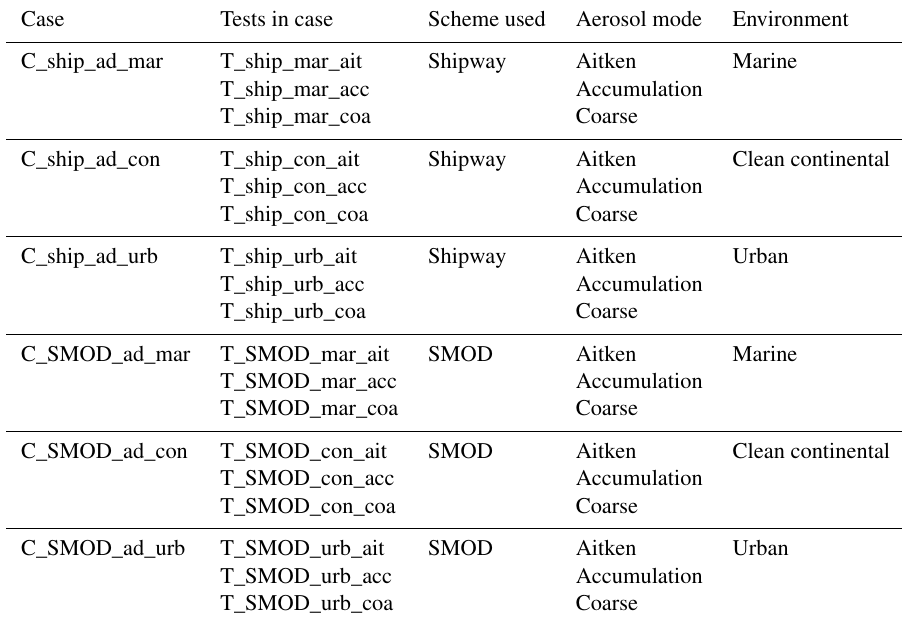
Table 2. The tests conducted in the offline box model that directly compared the Shipway and SMOD adiabatic mode based on Eqs. (4) and